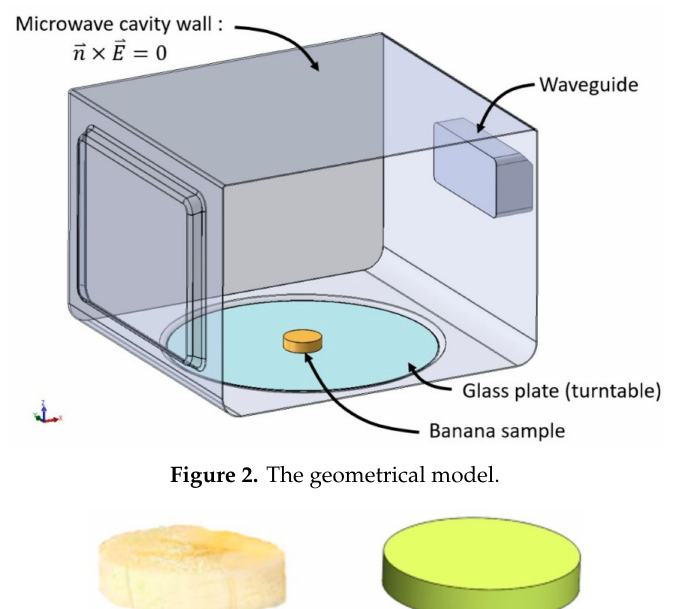
Figure 3. The sample geometry. ( a ) Transversal banana slice, and ( b ) geometry of banana slice used for